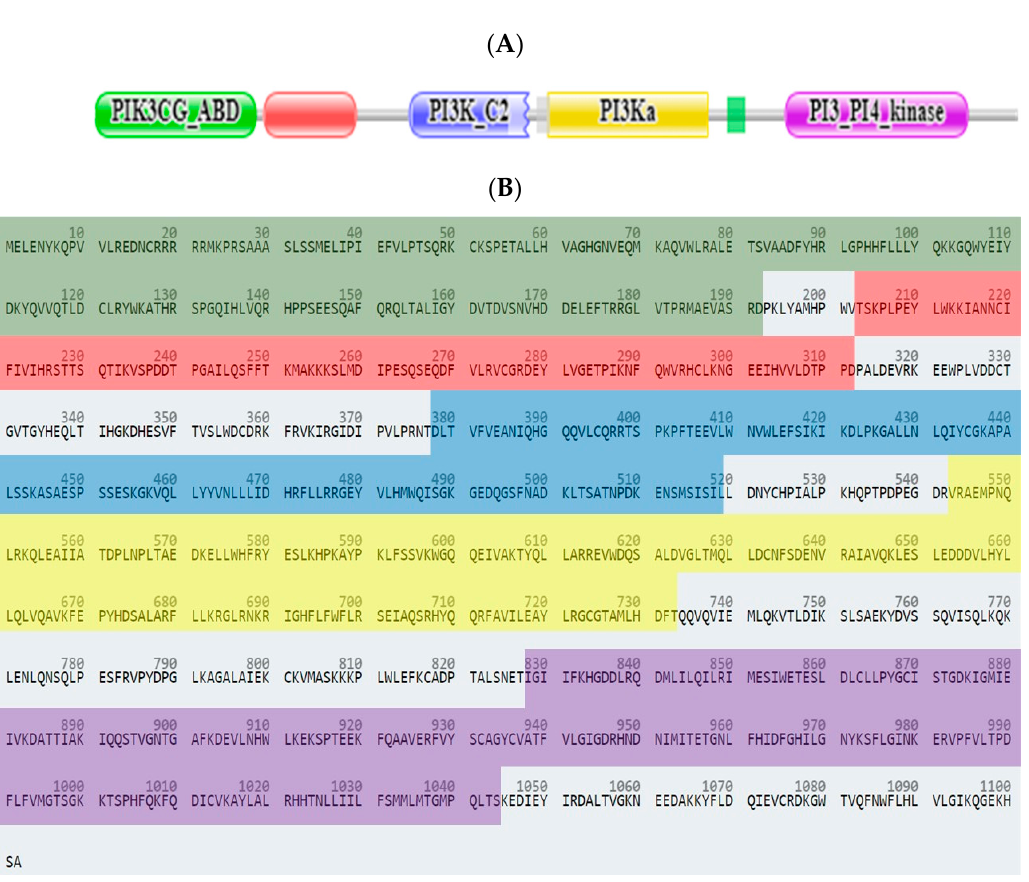
Figure 8. PI3K protein domains, ( A ) the arrangement of the Pfam domains, ( B ) the FASTA format of PI3K showing amino acid residues of 1. PIK3 catalytic subunit gamma adaptor-binding domain (green), 2. Ras-binding domain (red), 3. C2 domain (blue), 4. phosphoinositide 3-kinase family accessory domain (yellow), and 5. phosphoinositide 3/4-kinase domain (purple).